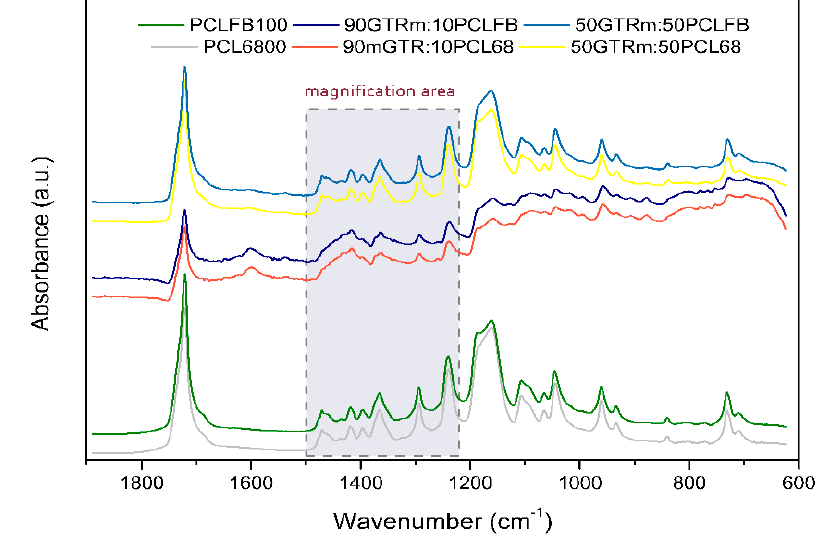
Figure 5. Fourier transform infrared spectroscopy (FTIR) spectra of analyzed RR / PCL blends.